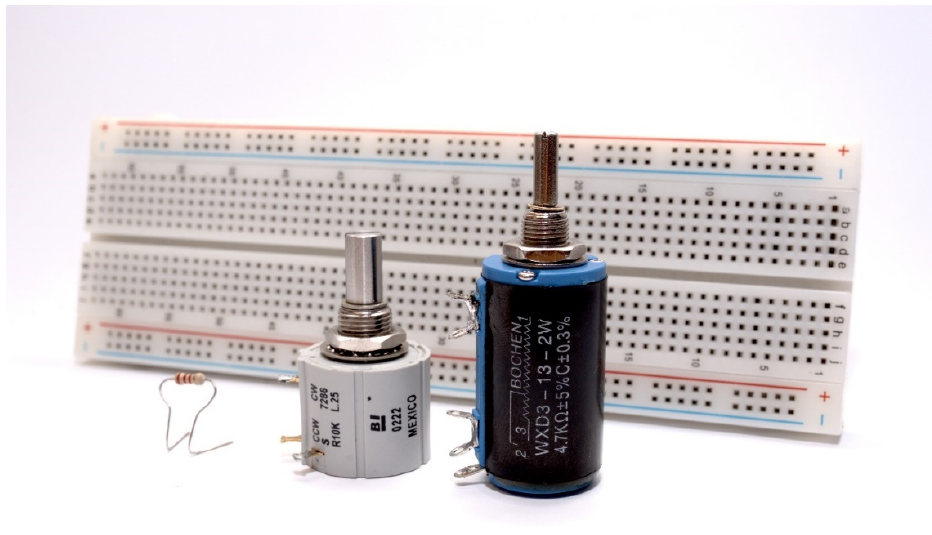
Figure 9. The subassemblies used in the experiment as EOL resistors of an EOL detection circuit in an intrusion detection system.